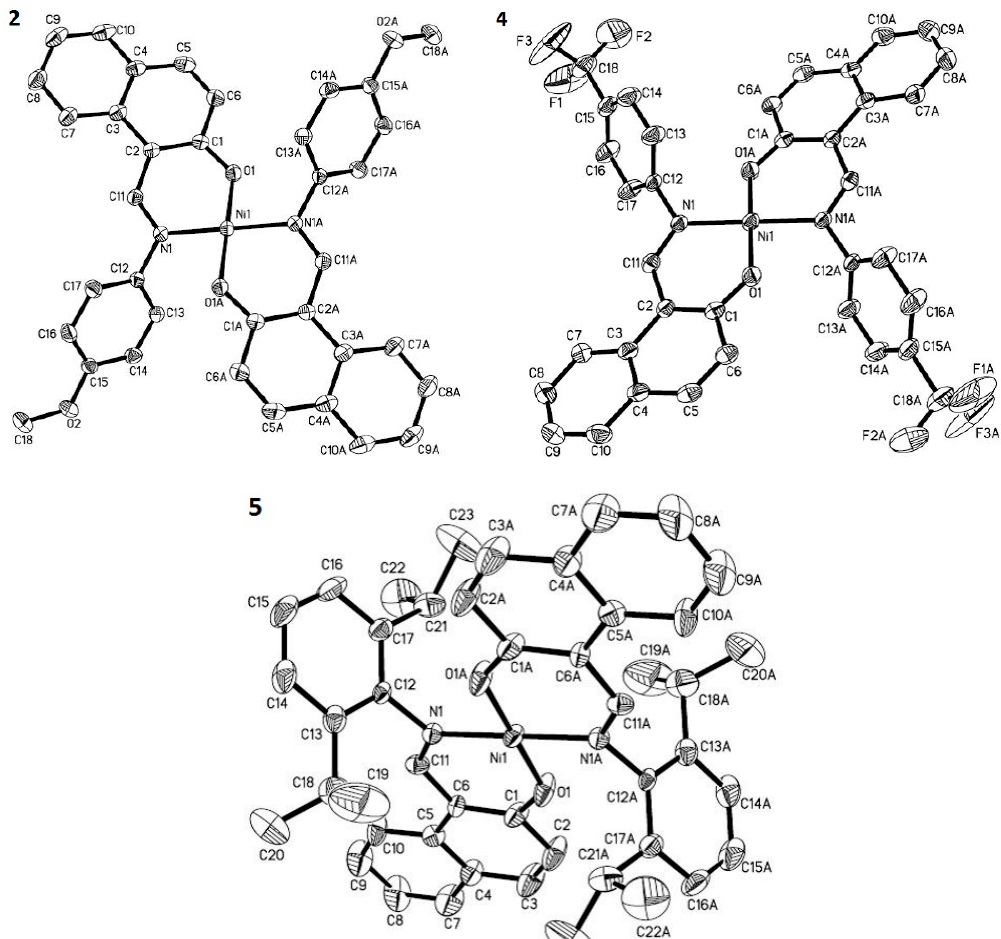
Figure 2. Molecular structures of 2 , 4, and 5 with 30% probability ellipsoids. Hydrogen atoms are omitted for clarity.